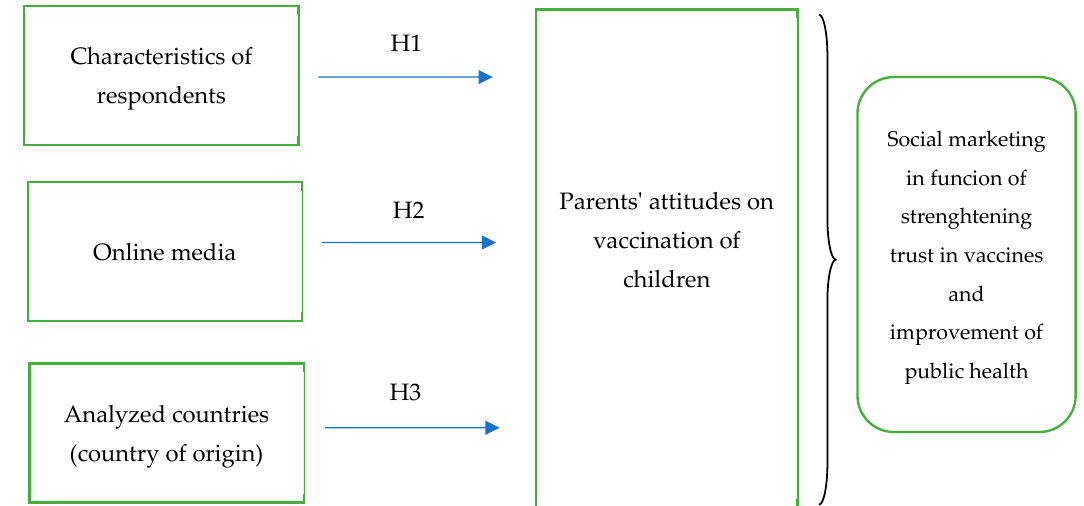
Figure 1. Conceptual model of research. Source: Authors.